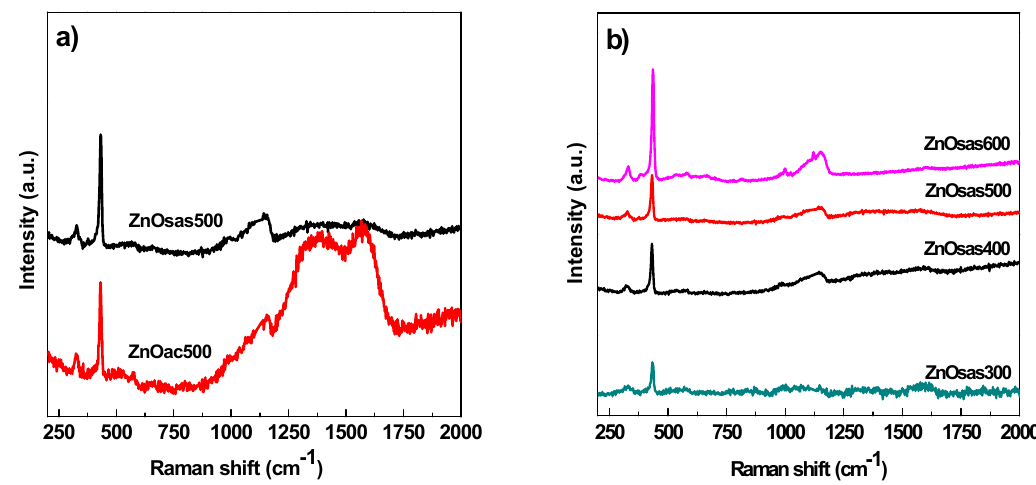
Figure 5. Raman shift of ( a ) zinc oxide (ZnO) from supercritical antisolvent (SAS) zinc acetate (ZnAc) nanoparticles calcined at 500 °C and ZnO from unprocessed ZnAc calcined at 500 °C; ( b ) ZnO from SAS ZnAc nanoparticles calcined at 300, 400, 500, and 600 °C.